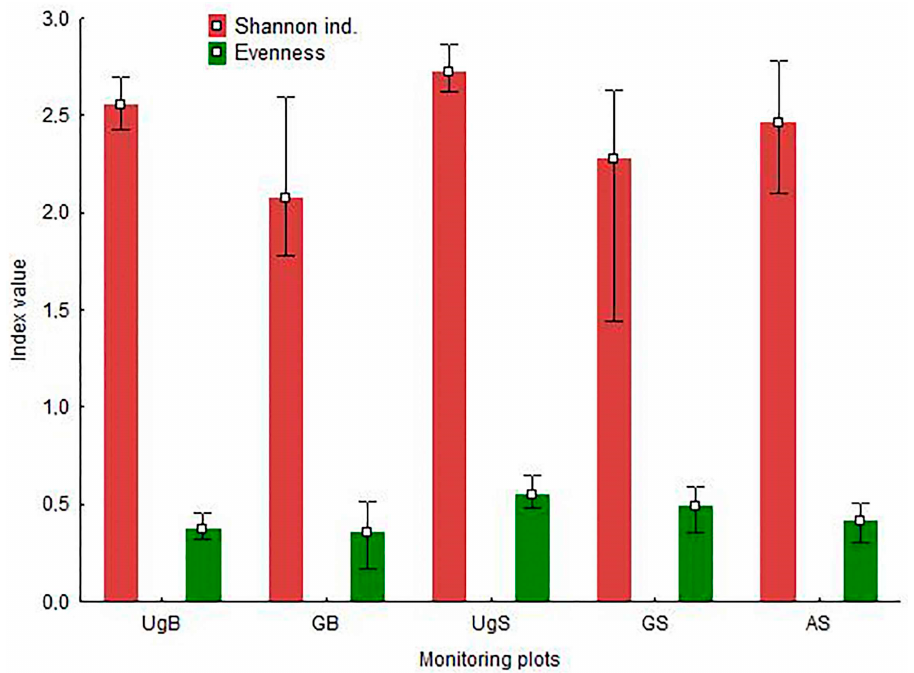
Figure 5. Alpha diversity of the ground-dwelling spider assemblages at the monitoring plots. Whiskers mean the non-outlier range. For the abbreviations, see Table 1.